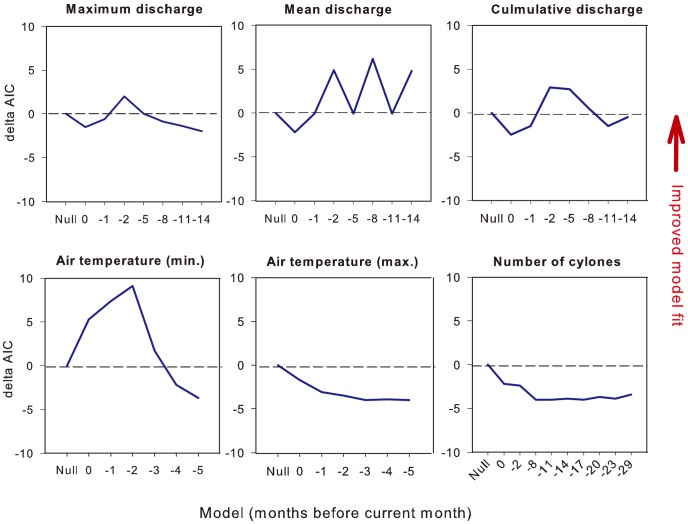
Fit of different additive models of inshore dolphin natural mortality as a function of environmental predictors at lags from zero (same month) up to 29 months (-29).Refer to the caption of Figure 3 for a full explanation.